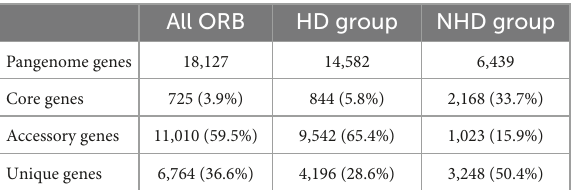
TABLE 1 Pangenome size of Oceanobacter -related bacteria and its different